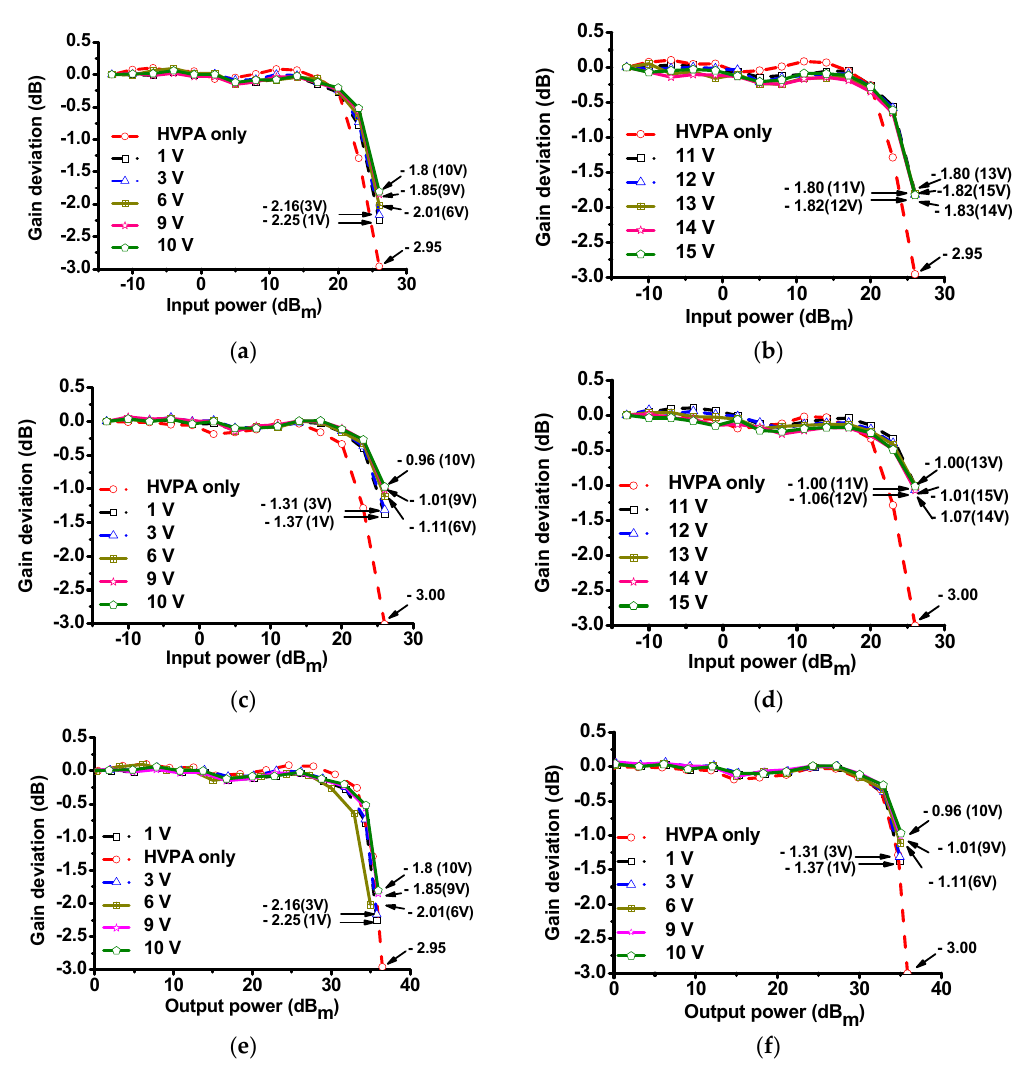
Figure 7. Normalized gain deviation of the HVPA with and without a power MOSFET linearizer vs. input power at ( a ) 70 MHz under DC bias voltages (1, 3, 6, 9, and 10 V DC, respectively), ( b ) under DC bias voltages (11, 12, 13, 14, and 15 V DC, respectively), at ( c ) 80 MHz under DC bias voltages (1, 3, 6, 9, and 10 V DC, respectively), at ( d ) 80 MHz under DC bias voltages (11, 12, 13, 14, and 15 V DC, respectively). Normalized gain deviation of the HVPA with and without a power MOSFET linearizer vs. output power at ( e ) 70 MHz under DC bias voltages (1, 3, 6, 9, and 10 V DC, respectively), and ( f ) at 80 MHz under DC bias voltages (1, 3, 6, 9, and 10 V DC, respectively).